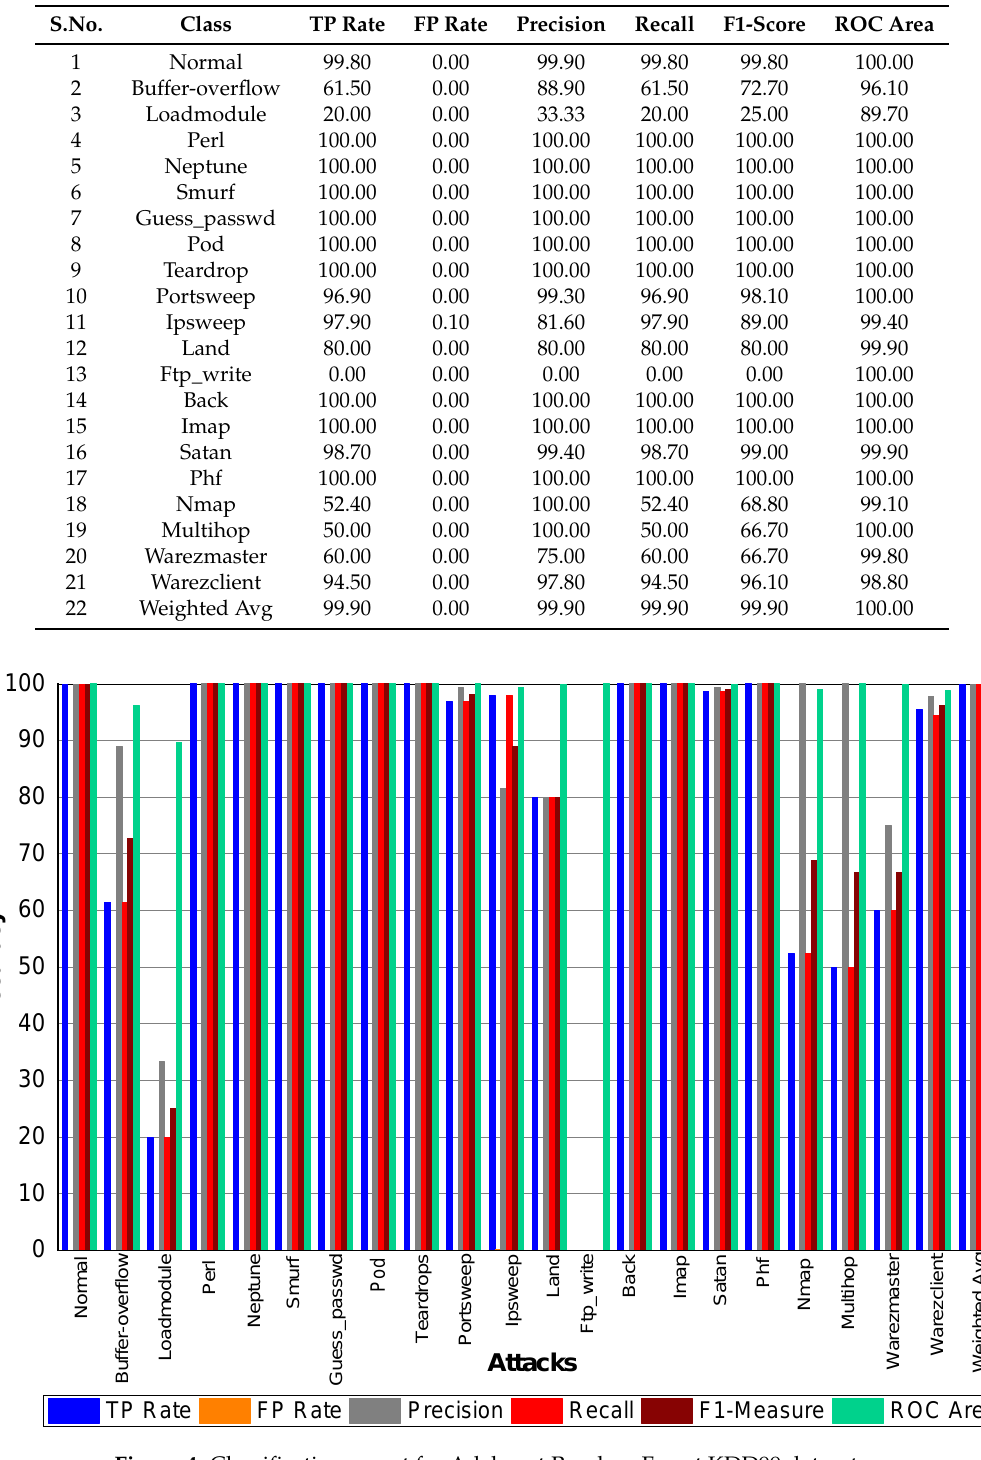
Figure 4. Classification report for Adaboost Random Forest KDD99